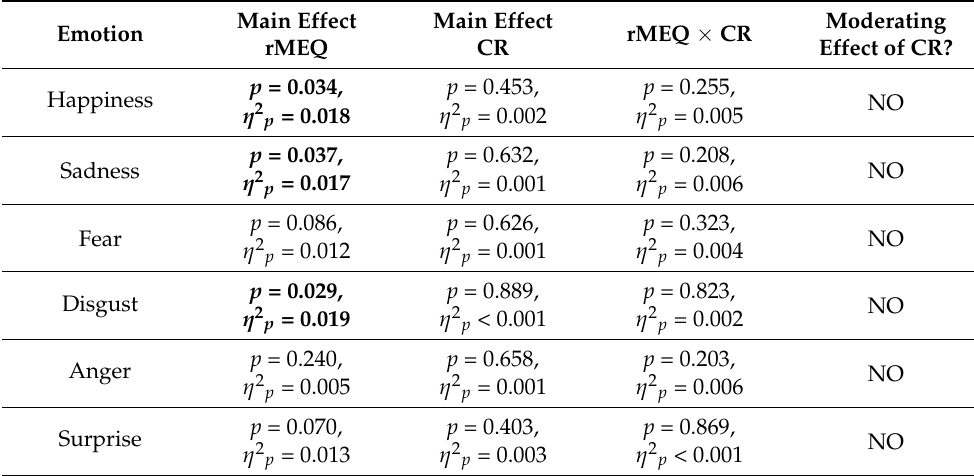
Table 2. Overview of models with cognitive